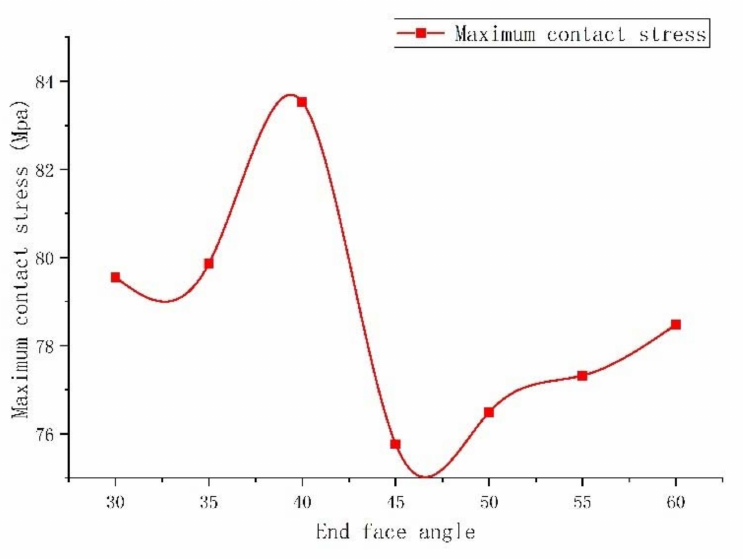
Figure 9. Surface contact stress nephogram of rubber packing element with different inclusion angles under the action of 100 T setting-down force.